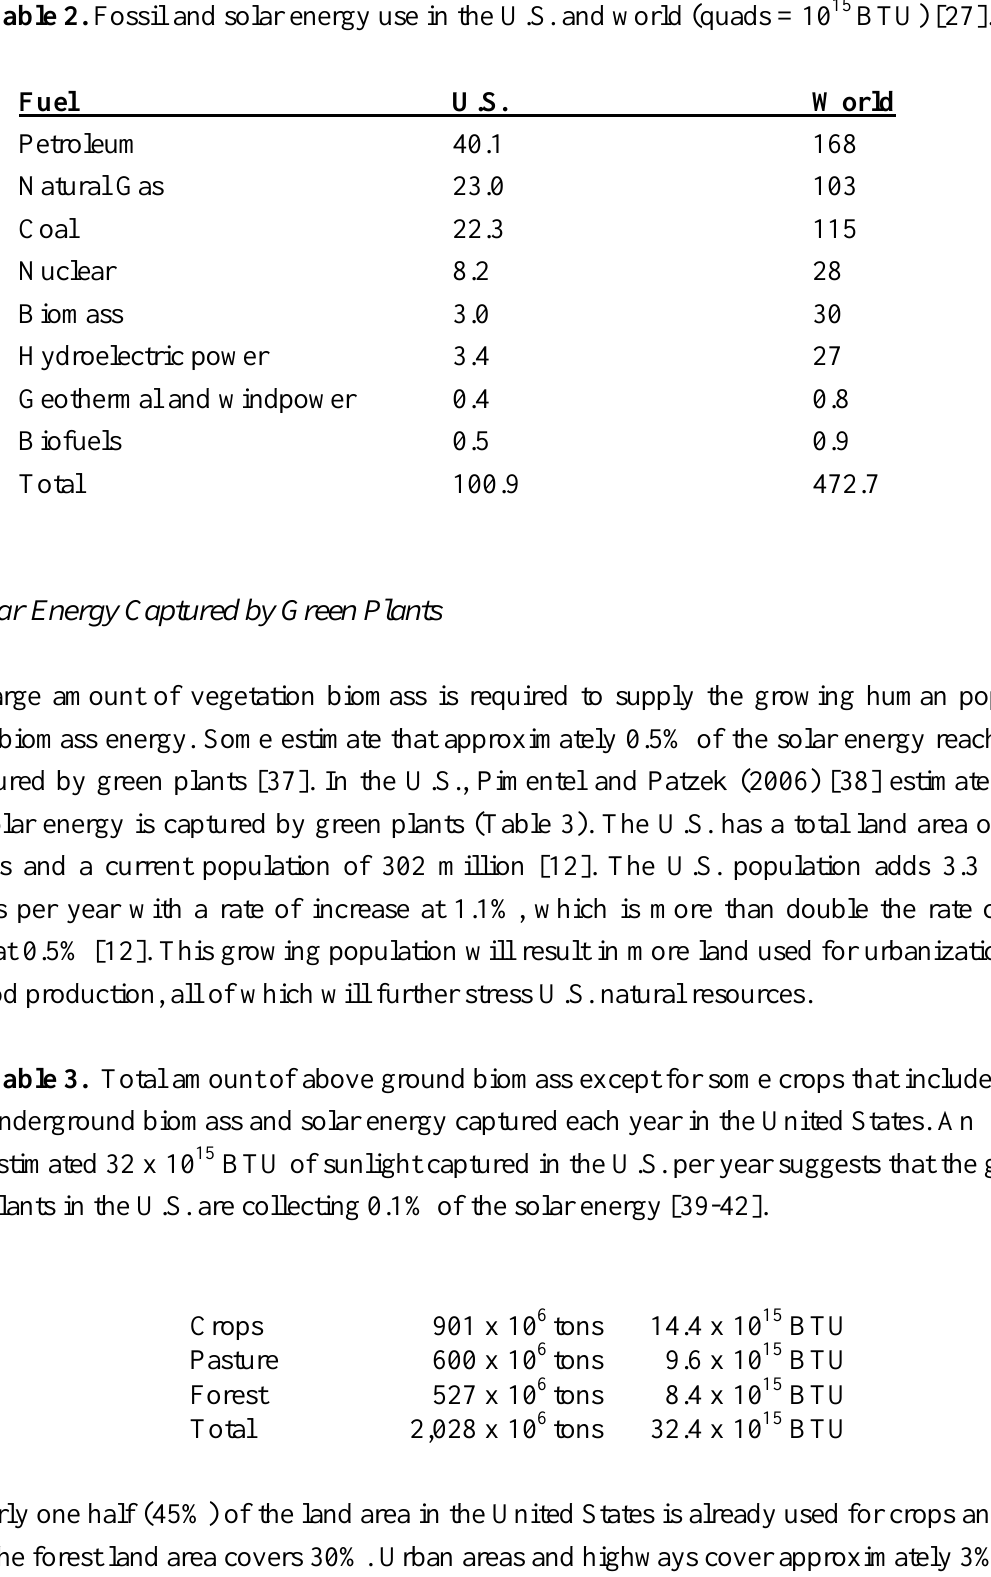
Table 2. Fossil and solar energy use in the U.S. and world (quads = 10 15 BTU)